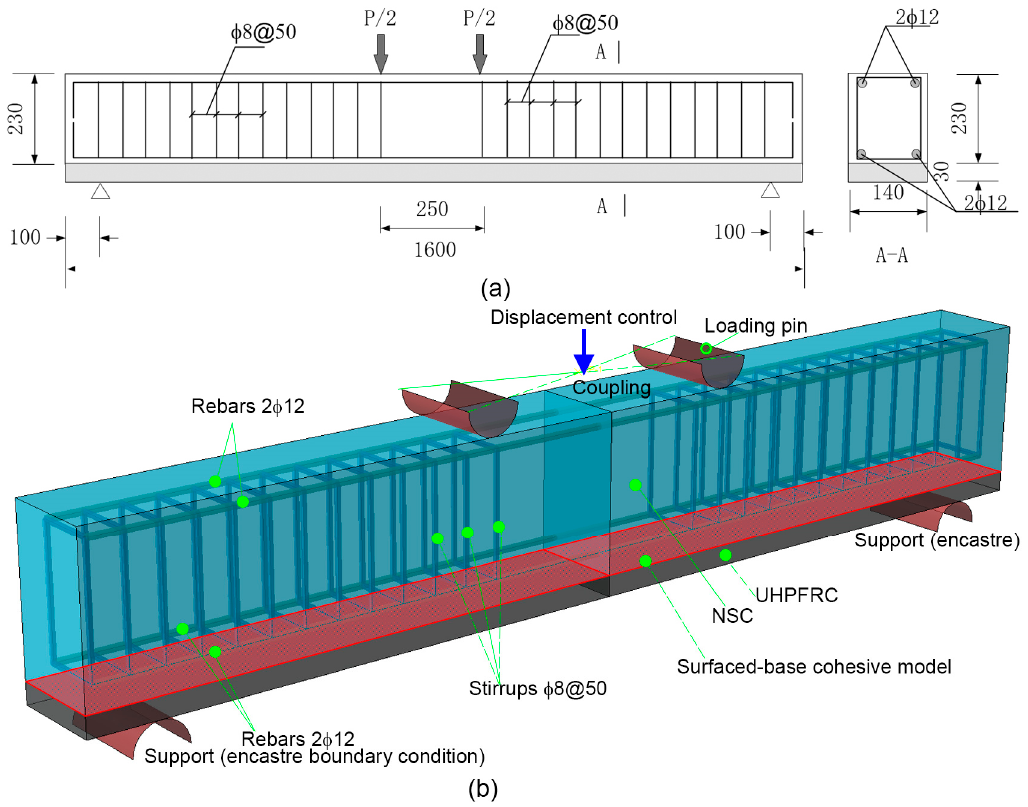
Figure 9. Flexural test: ( a ) geometry and reinforcements of the NSC-UHPFRC composite beam [36]; and ( b ) FE model.